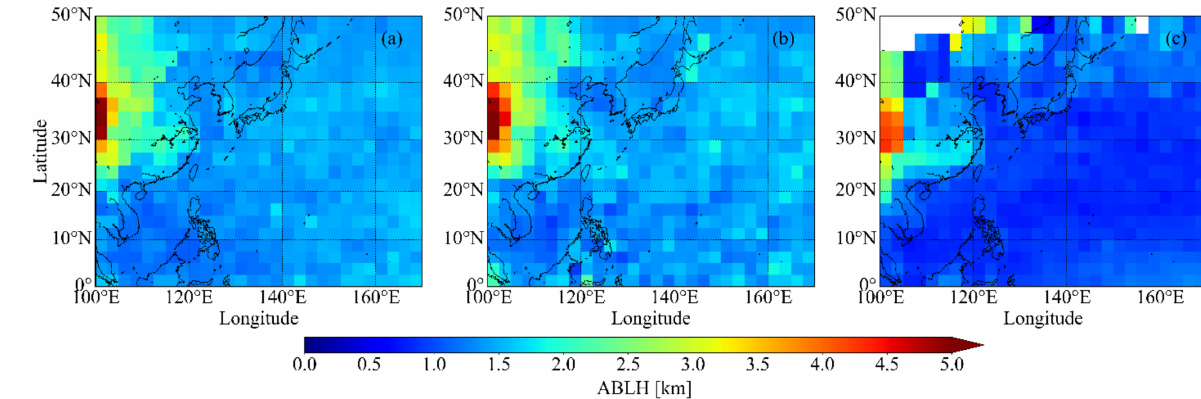
Figure 6. ABLH climatology during the local typhoon season (July–October). ( a , b ) are the results of reprocessed and post-processed COSMIC data, and ( c ) is the result of COSMIC-2